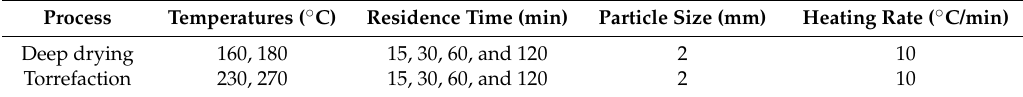
Table 2. Experimental design for the deep drying and torrefaction